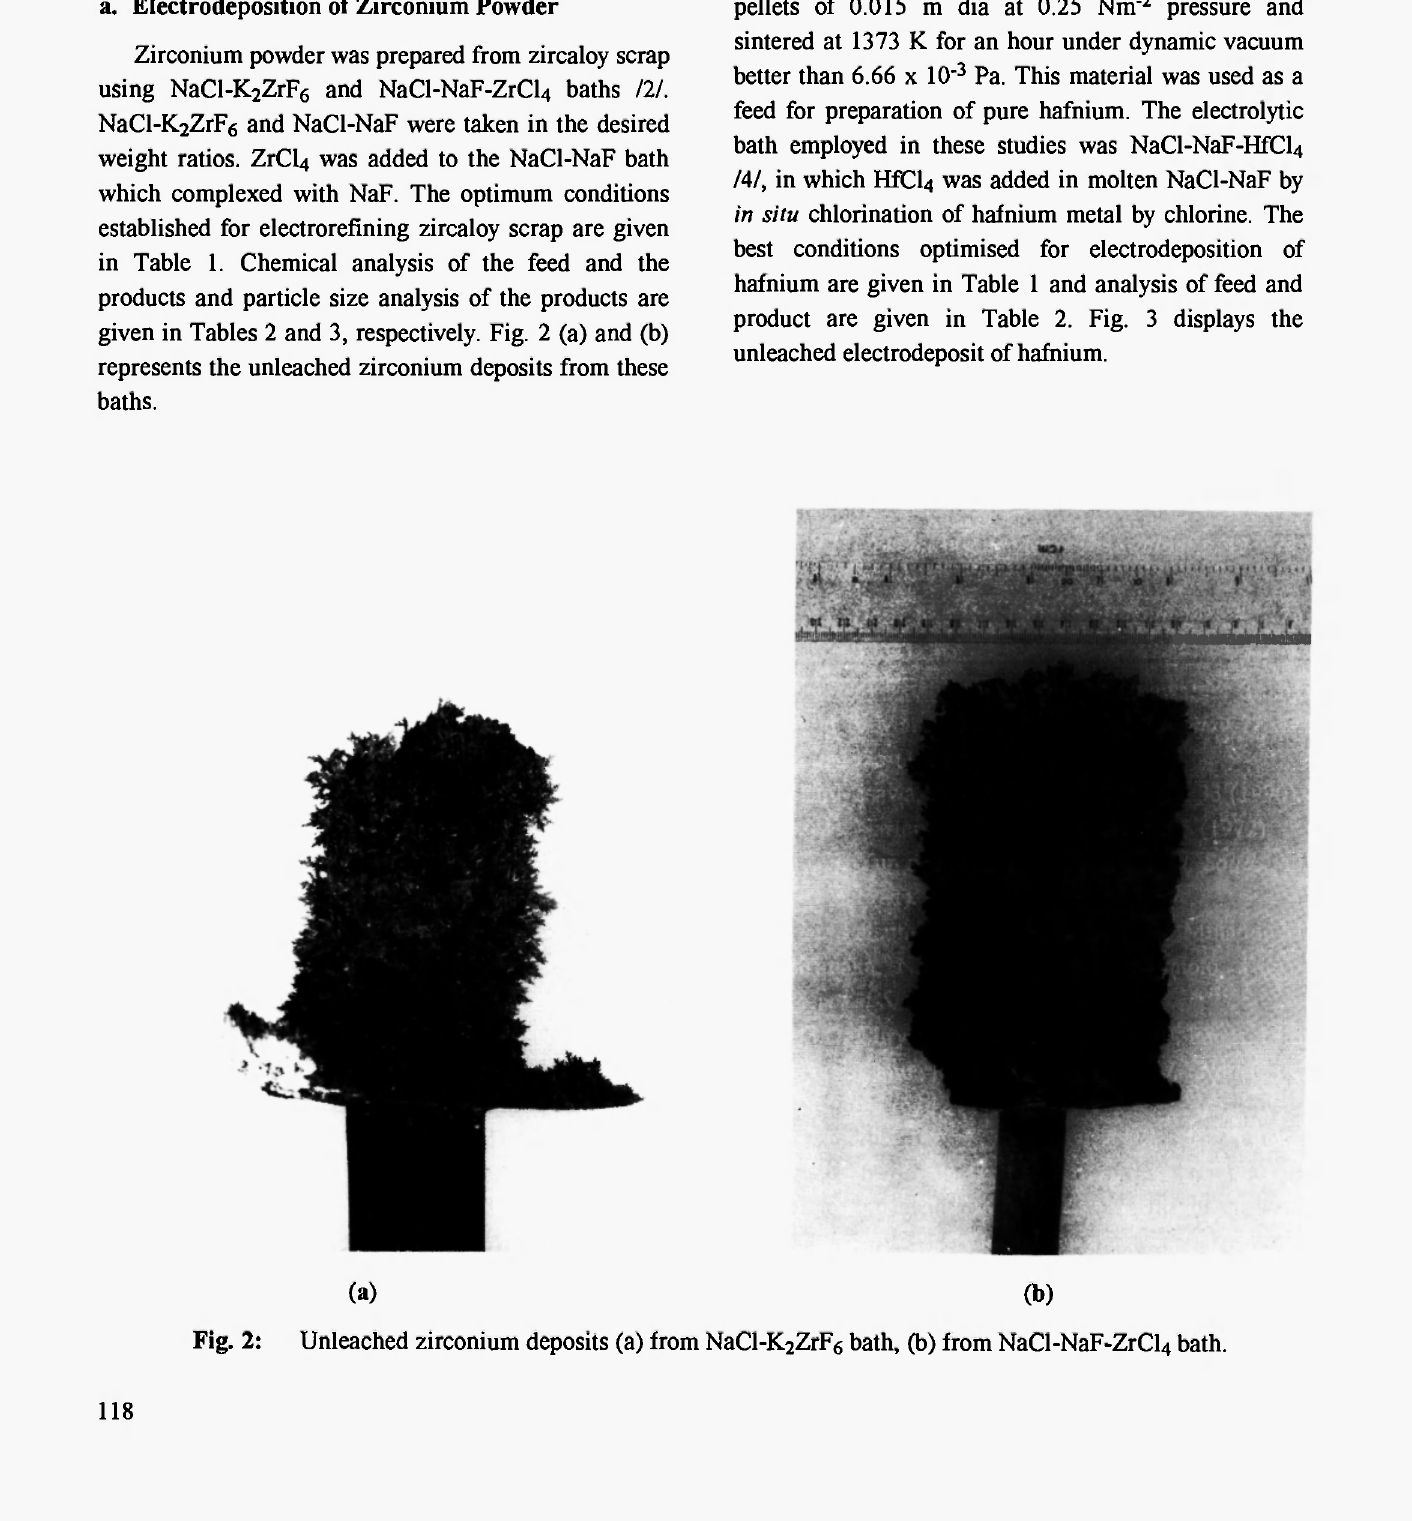
ZrF bath, (b) from NaCl-NaF-ZrCl 2 6